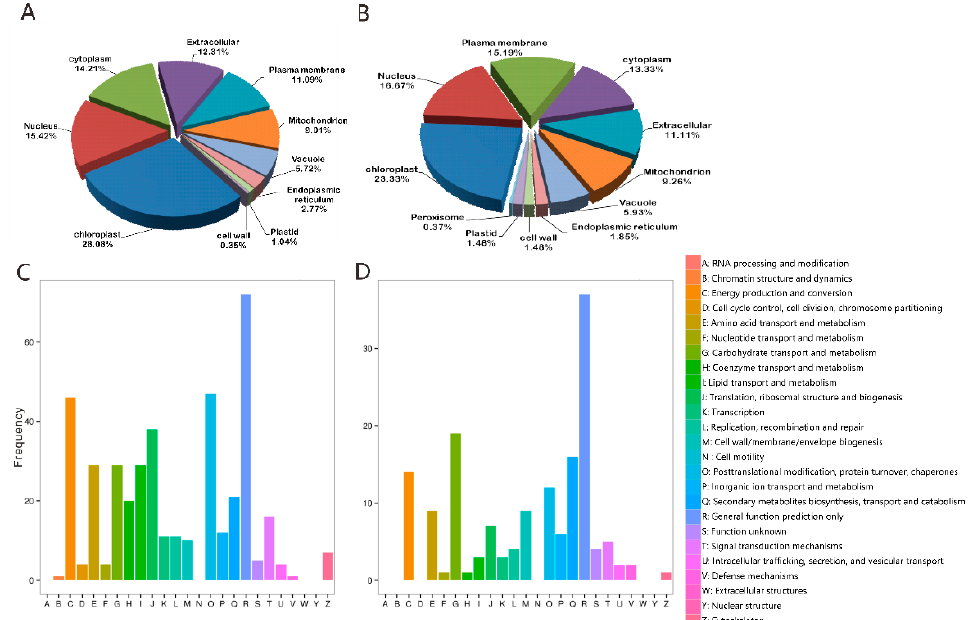
Figure 4. Subcellular localization (upper) and functional categories according to clusters of orthologous groups of DEPs (bottom) in the S-D stressed mulberry leaves ( A , C ) and roots ( B , D ).